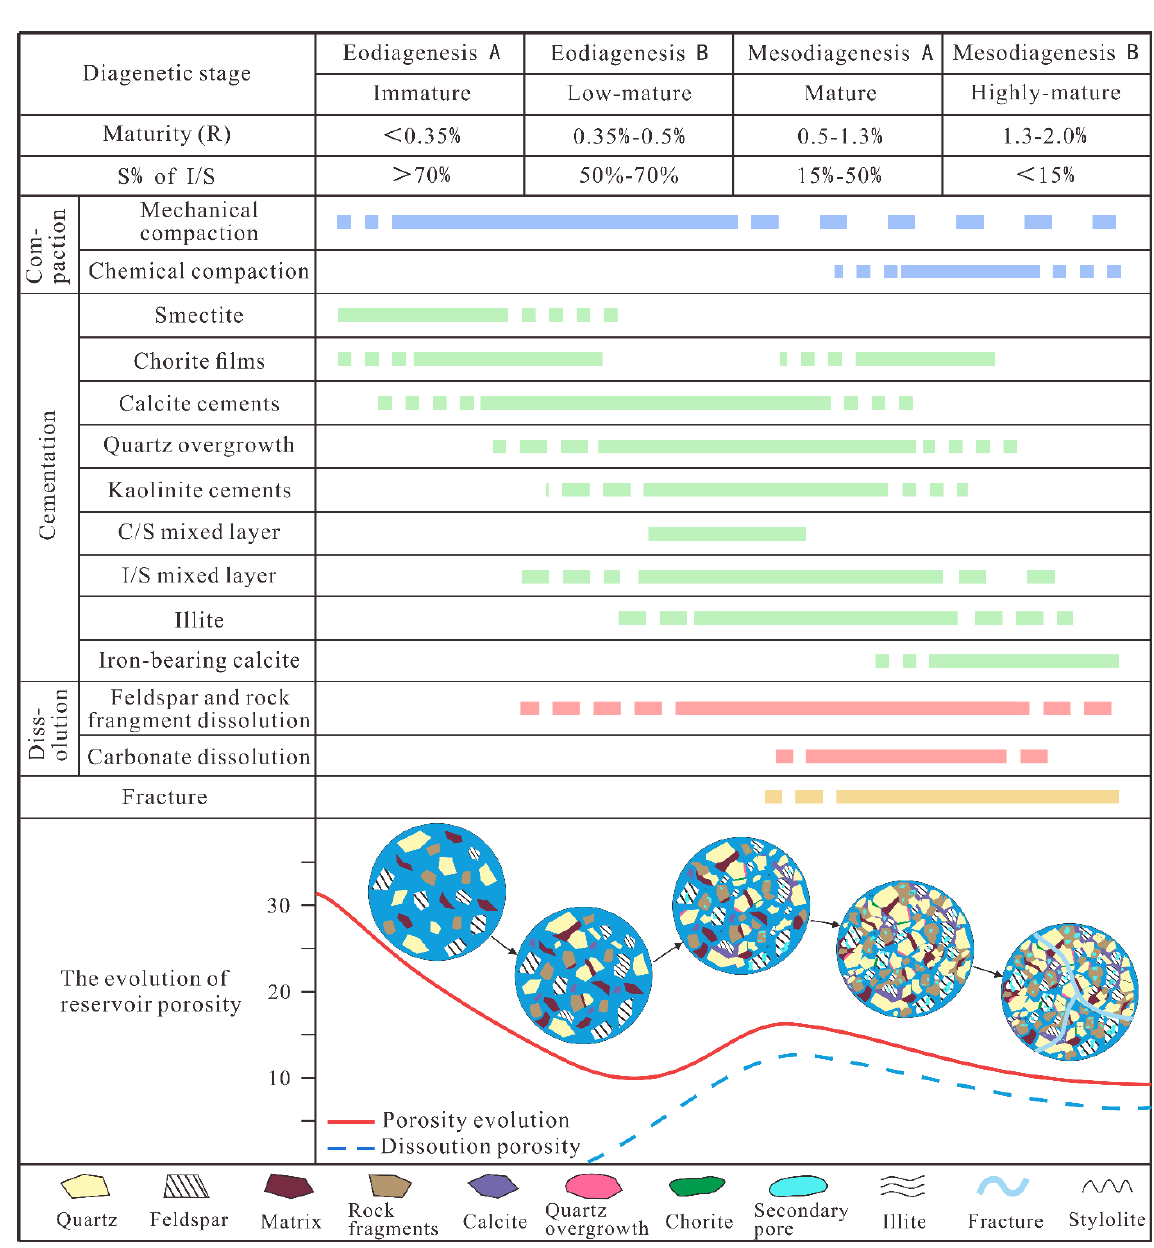
Figure 10. Diagenetic sequence of the Lower Jurassic reservoir in the Niudong area, northern margin of Qaidam Basin.